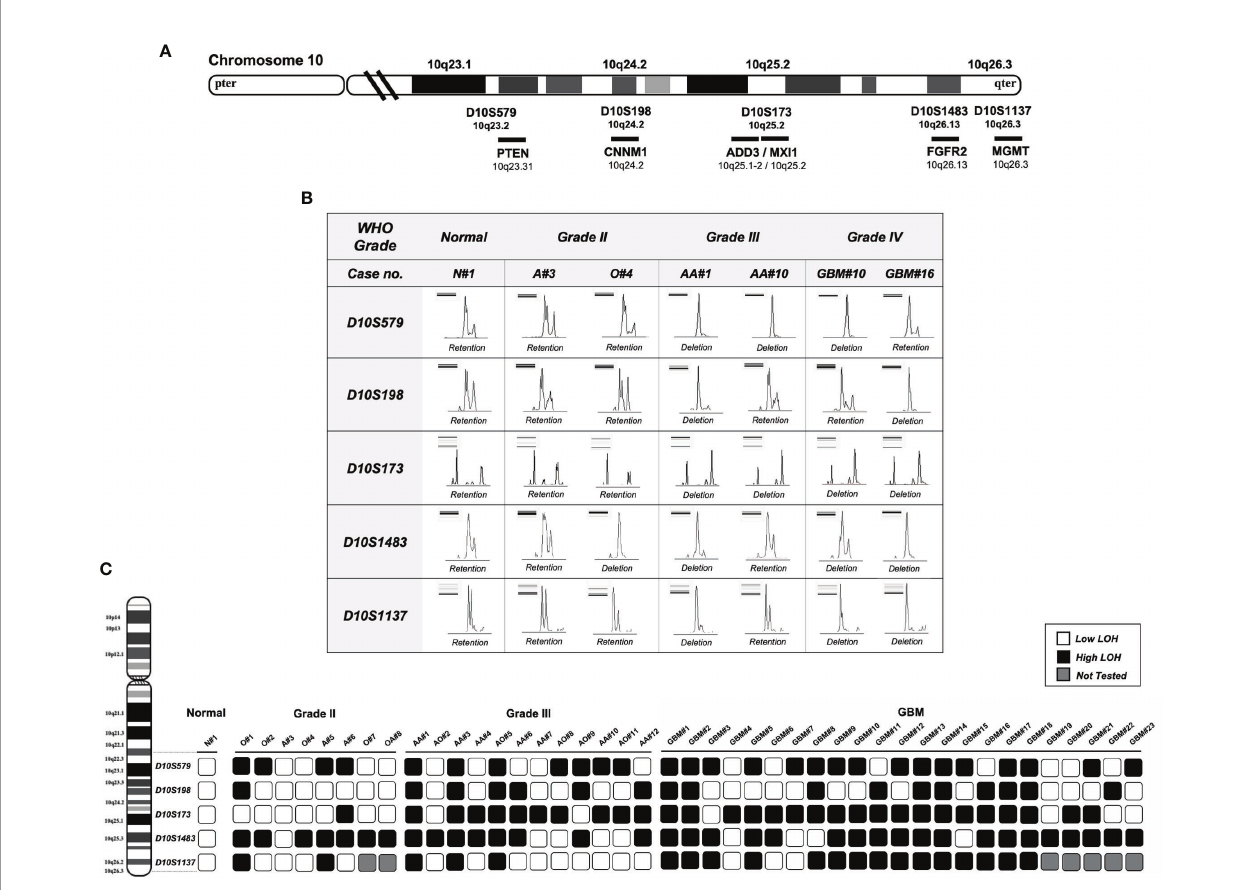
FIGURE 1 | Deletion mapping of chromosome 10q using PCR-based loss of heterozygosity (LOH) analysis. (A) The fi ve polymorphic microsatellite markers from 10q23 to 10q26 (D10S579, D10S198, D10S173, D10S1483, and D10S1137) and the corresponding chromosomal loci fl anking or intragenic of the gene locus (chromosome map based on UCSC GRCh37/hg19 assembly). (B) Assessment of allelic loss in fragment analysis on an automated capillary electrophoresis system (from seven representative cases). Allelic status was calculated based on the peak intensity ratios in gliomas relative to normal brain tissue. LOH ratio of >0.5 or < 1.5 is de fi ned as a low level of LOH, and a ratio of ≤ 0.5 or ≥ 1.5 is de fi ned as a high level of LOH. DNA bands from gel electrophoresis are indicated on the top left corner of each panel. (C) Deletion map of 43 glioma specimens. Case numbers are indicated at the top of each column. Open and solid boxes represent low and high levels of LOH, respectively. Boxes in gray were not tested. N, normal; A, astrocytoma; O, oligodendroglioma; AA, anaplastic astrocytoma; AO, anaplastic oligodendroglioma; GBM,